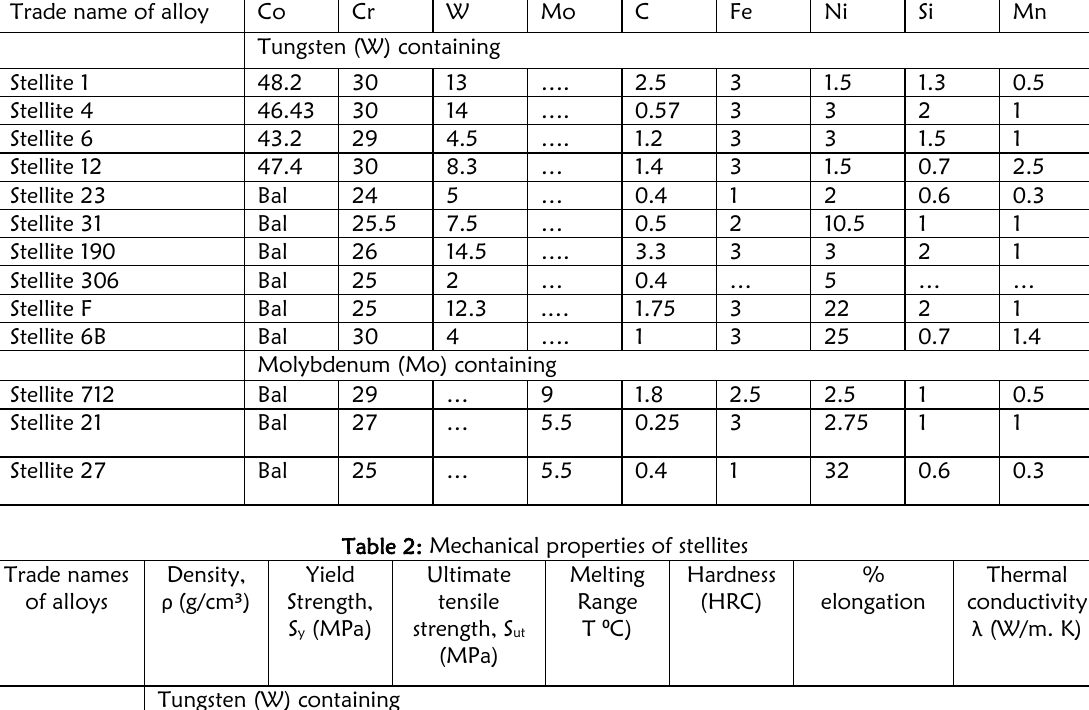
Table 1: Chemical composition of stellites (weight %)